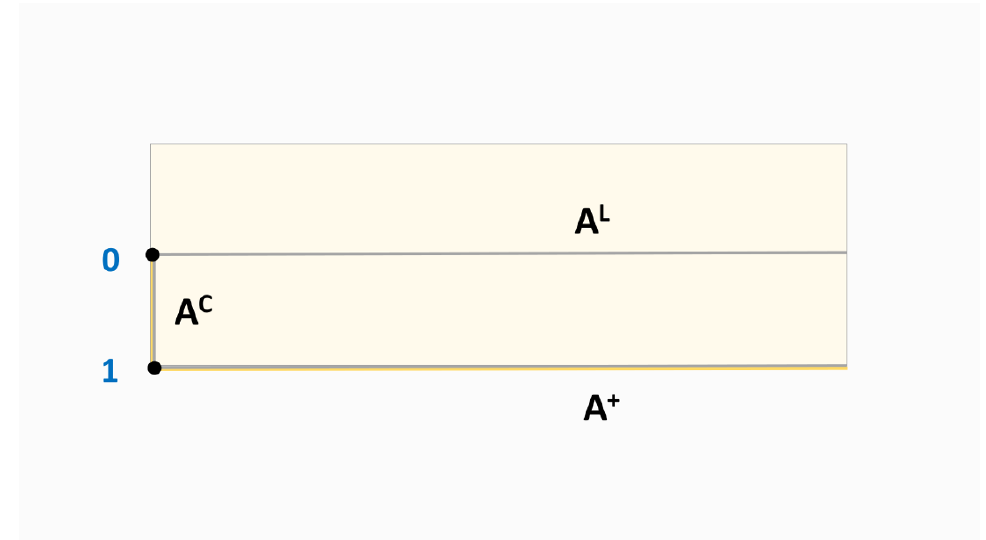
Figure 1 . The fundamental domain D of the P¨oschl-Teller problem is a semi-infinite cylinder whose end is squashed to an interval. It is obtained from the semi-infinite strip by gluing the horizontal lines on top and bottom. Within this domain, the potential diverges at two points u 0 = iπ and u 1 = 0 (black dots). Different Schr¨odinger problems can be obtained, depending on the choice of a real subset A . The figure shows three possible choices, A + , A L = ˜ A + and A C . The eigenvalue equations on A + and A L are related by a shift ̺ that involves the reflection of the coupling constant b and they both lead to a continuous spectrum. The 1-dimensional Schr¨odinger problem on the compact interval A C possesses a discrete